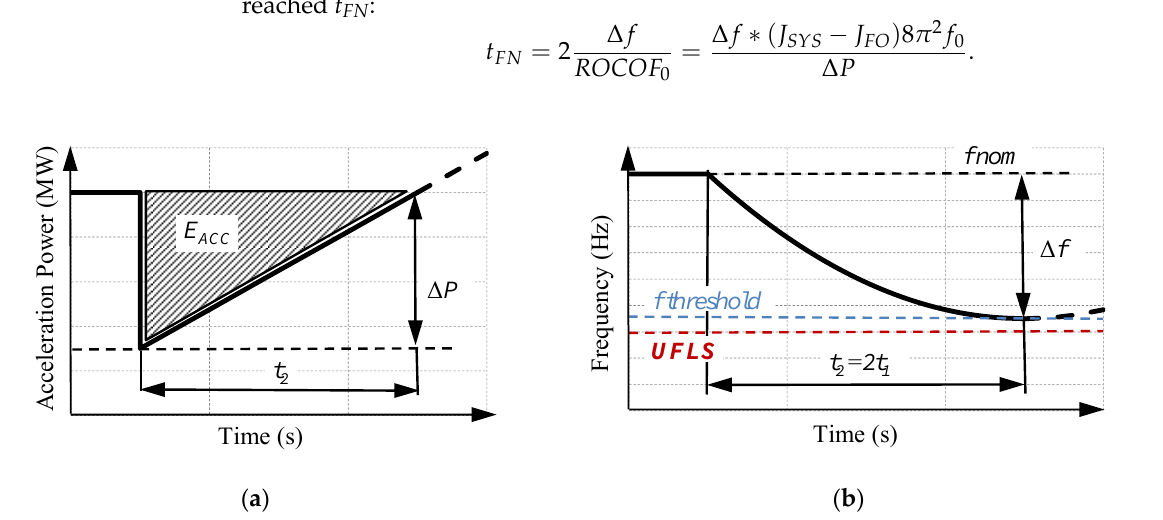
Figure 2. ( a ) Linear change in acceleration power; ( b ) quadratic frequency deviation.